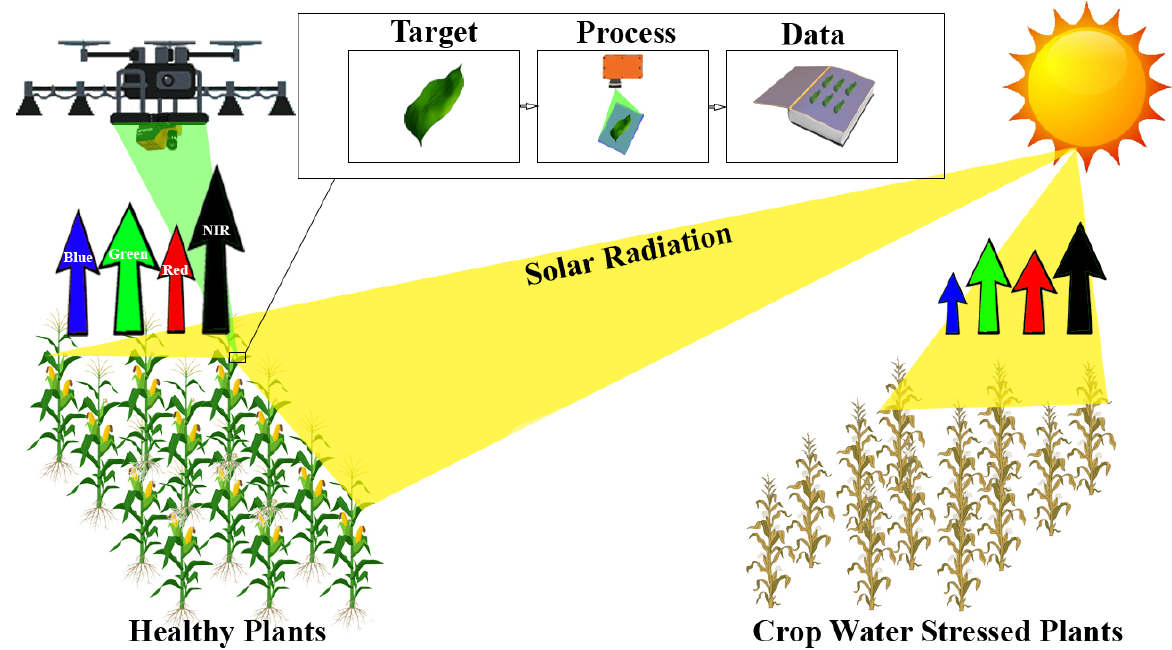
Figure 6. Remote–sensing hyperspectral camera system is used to analyze crop water stress (in both healthy and stressed plants), identify gaps in crop production, and provide suggestions to mitigate with stress conditions.